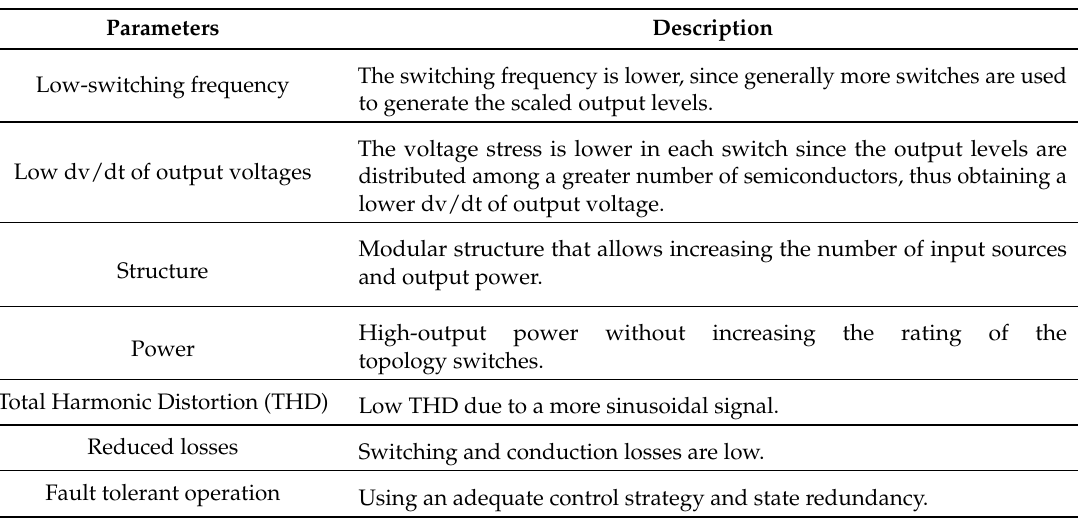
Table 2. Main multilevel inverters advantages.